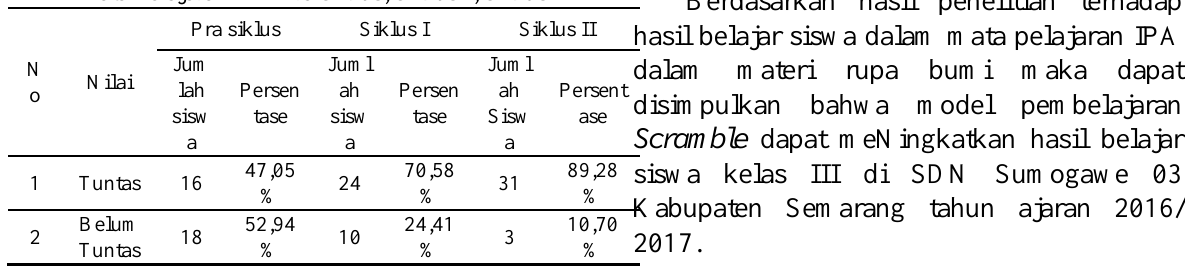
Tabel 6. Perbandingan Distribusi Frekwensi Nilai Mata Pelajaran IPA Pra Siklus, Siklus I, Siklus